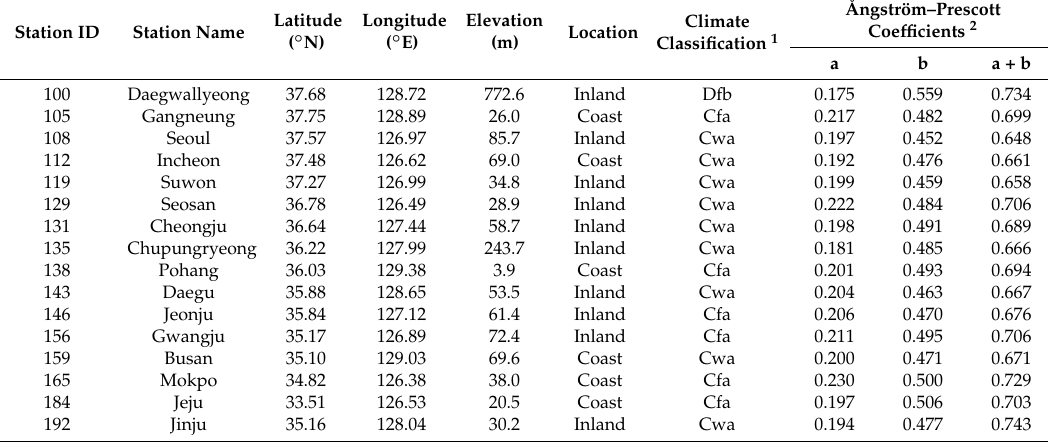
Table 1. Geographic characteristics of the meteorological stations and the Ångström–Prescott coefficients used in this